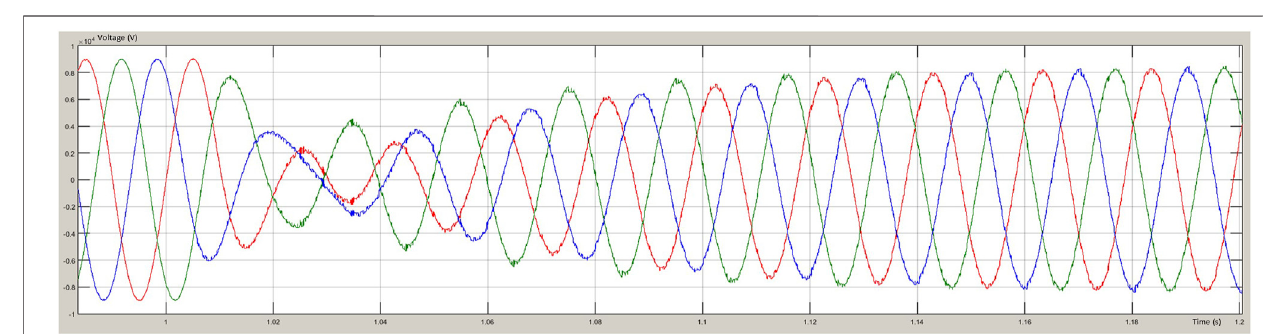
FIGURE 10 | Transition from grid to BESS.